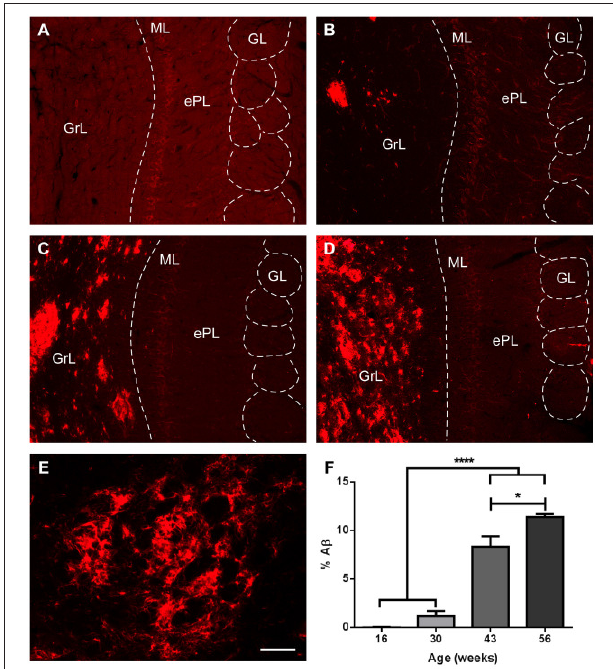
FIGURE 7 | Amyloid β aggregation over time in the olfactory bulb of transgenic animals. (A–D), %A β aggregates in transgenic mice at 16, 30, 43, and 56 weeks, respectively. (E) , high power of a plaque. (F) , graphics illustrating % of area occupied by A β , virtually restricted to the granule cell layer. Calibration bar for (A–D) , 80 µ m, for E, 20 µ m. * P < 0.05 , **** P < 0.0001